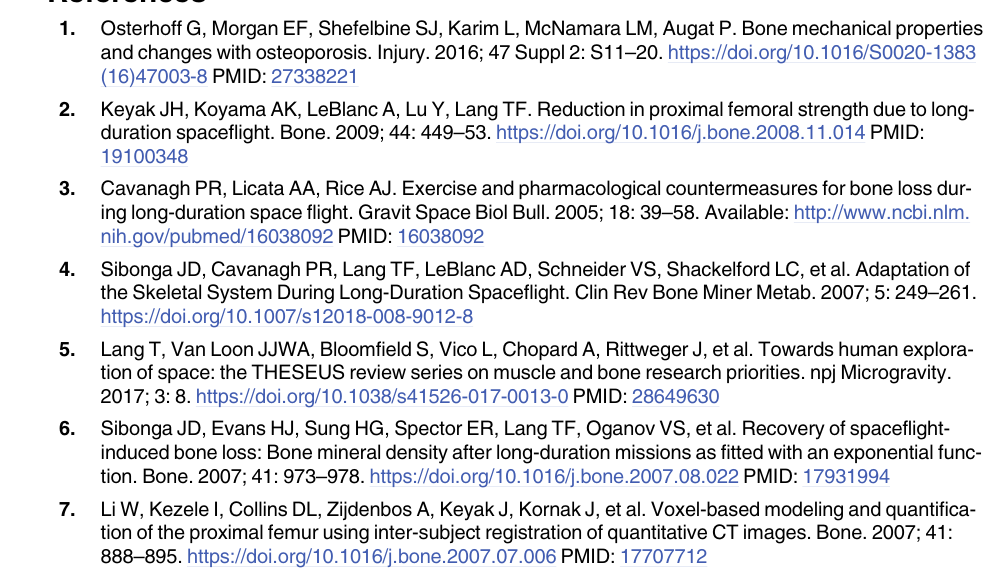
S4 Table. Predicted BMD loss in the femoral neck of crewmembers of different ages and ethnicities in a conjunction-class mission to Mars with a total duration of 1200 days. S5 Table. Predictions of percent loss in bone mineral density at fermoral neck in astro- nauts using data from astronauts (N = 69) after 132- to 228-day spaceflights.